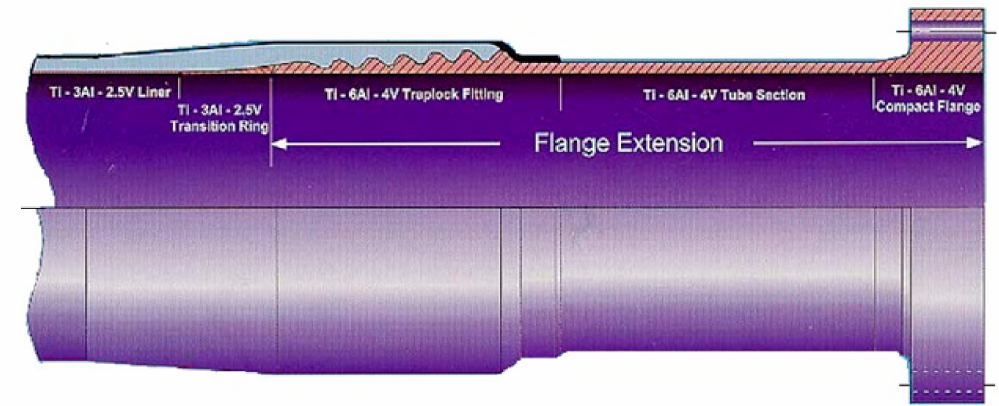
Figure 21. The Traplock end-fitting of the first composite riser joint showing the MCI sketch of the composite drilling riser by NCAS/KOP on the Heidrun Platform. [Permission was obtained from Elsevier Publishers, Source: [65,66,199]; Published: 12 July 2005; Copyright date: 2005].